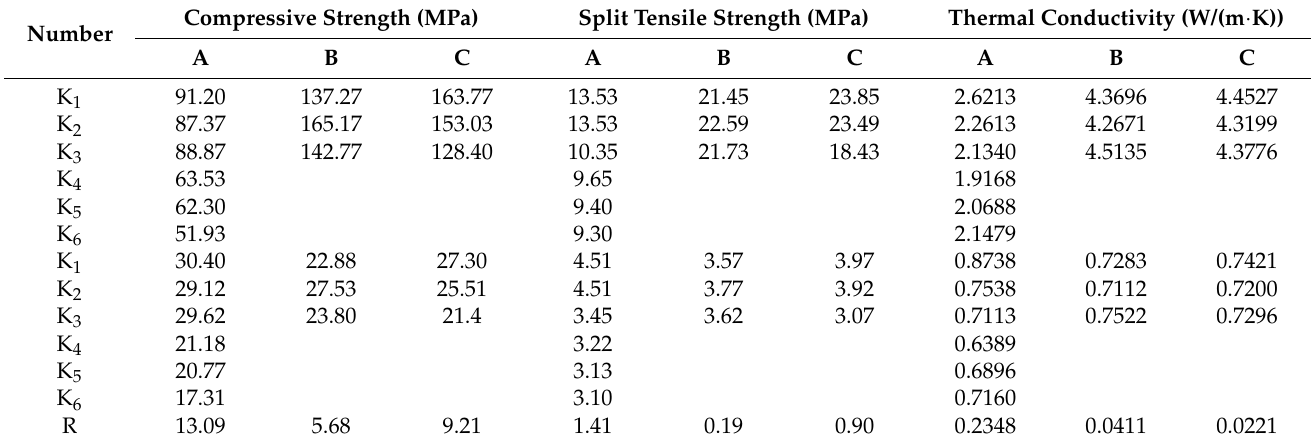
Figure 3. Range chart. Table 5. Analysis results of range.